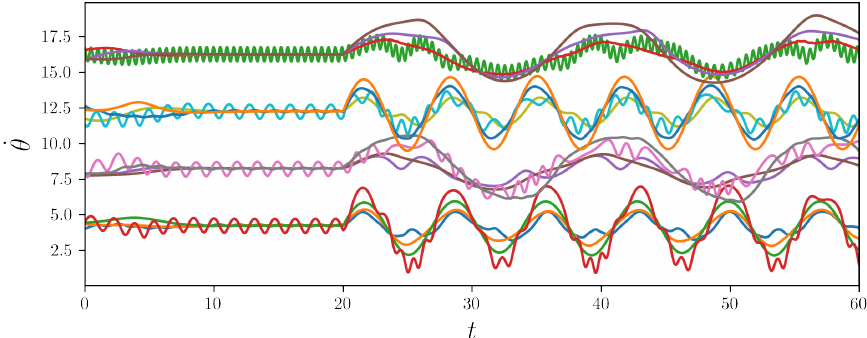
Figure 2. Trajectories of Equation (7) with sinusoidal U i and significant differences between µ i from different components of the communication graph: the clusters are “flowing” over